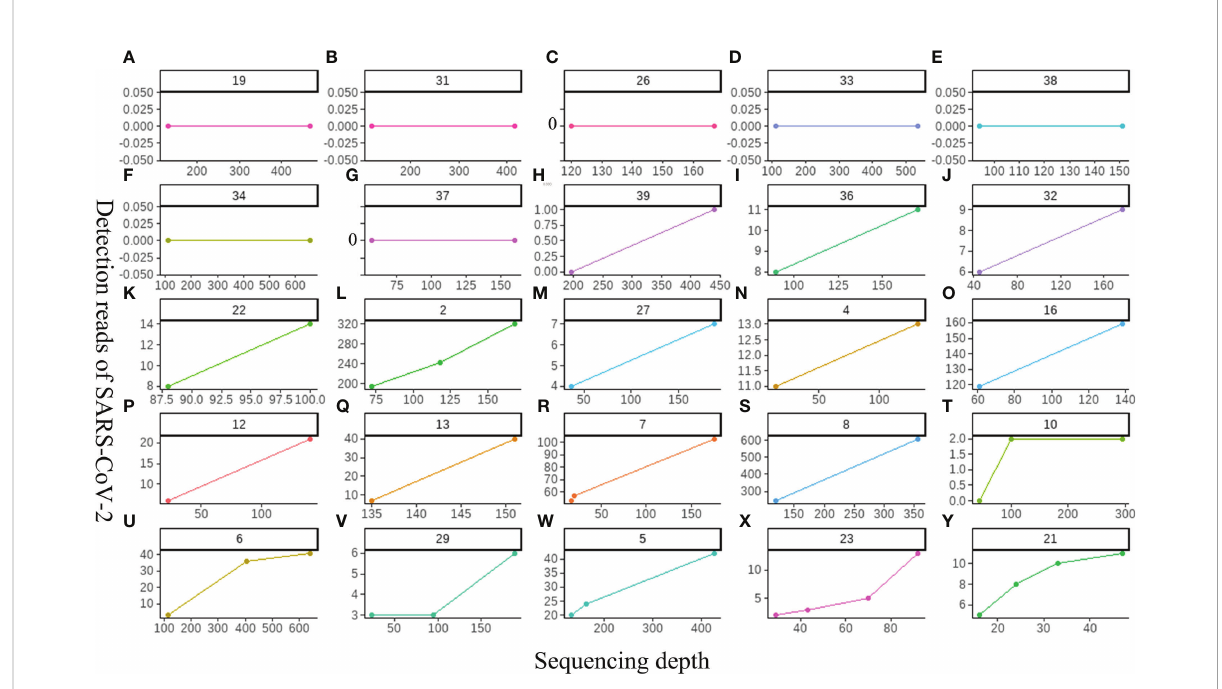
FIGURE 5 The relationship between the sequencing depth and the detection sensitivity of SARS-CoV-2 based on untargeted host-removed mNGS technology. (A-Y) 25 samples were assayed by mNGS using sequencing depth,